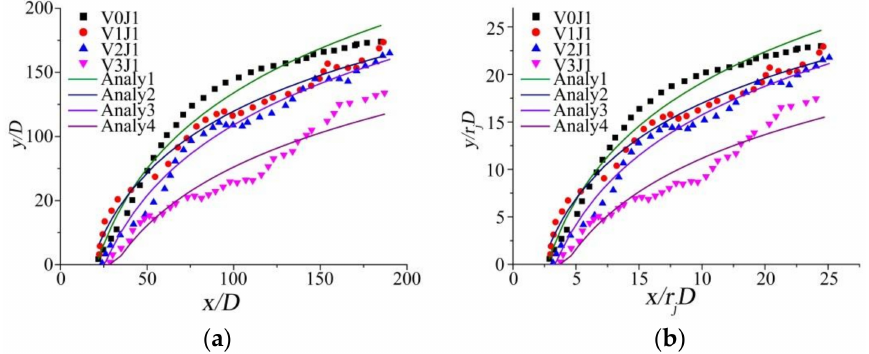
Figure 7. Jet axis motion trajectory. ( a ) Coordinates are normalized by D ; ( b ) Coordinates are normalized by r j D